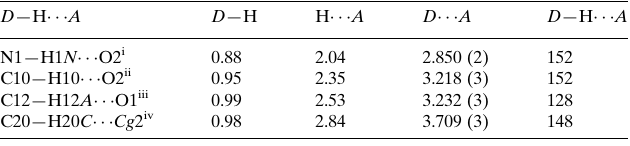
Hydrogen-bond geometry (A˚ , (cid:2) ). Cg 2 is the centroid of the C14–C19